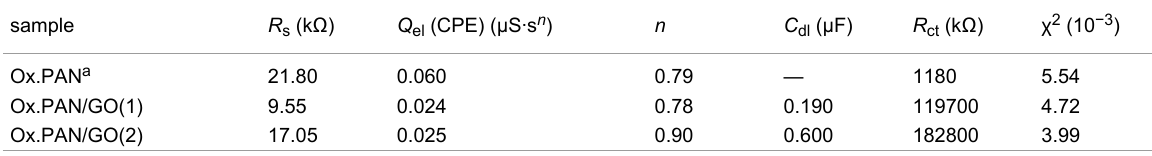
Table 1: Fitting values for the equivalent circuit elements by simulation of the impedance spectra of oxidized nanofibers. sample